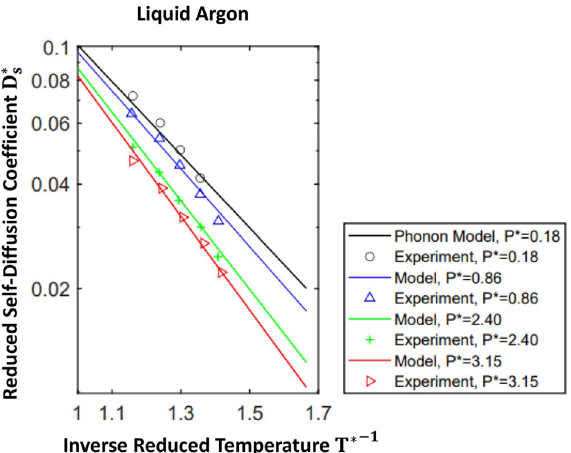
Figure 3. Temperature-dependent self-diffusion coefficient of liquid argon. Over the spectrum of frequencies ω (cid:31) ω d , the phonon self-diffusion model: (i) idealizes the band from the available to a liquid state system, 0 ≤ Frenkel frequency, ω F solid-state-like dynamics, (ii) assumes that on ω F (cid:31) ω (cid:31) ω d , individual molecules undergo small amplitude, harmonic vibrations about fixed positions, and (iii) thus allows a normal mode analysis of the solid-like dynamics. In order to capture the observed temperature dependence of D ∗ s 38 , it is necessary to assume that the band of phonon frequencies driving self-diffusive, single molecule random hops is concentrated near the low ω F , idealized as a delta function in (27). The nondimensional definition of end of the solid state spectrum, ω ≈ D